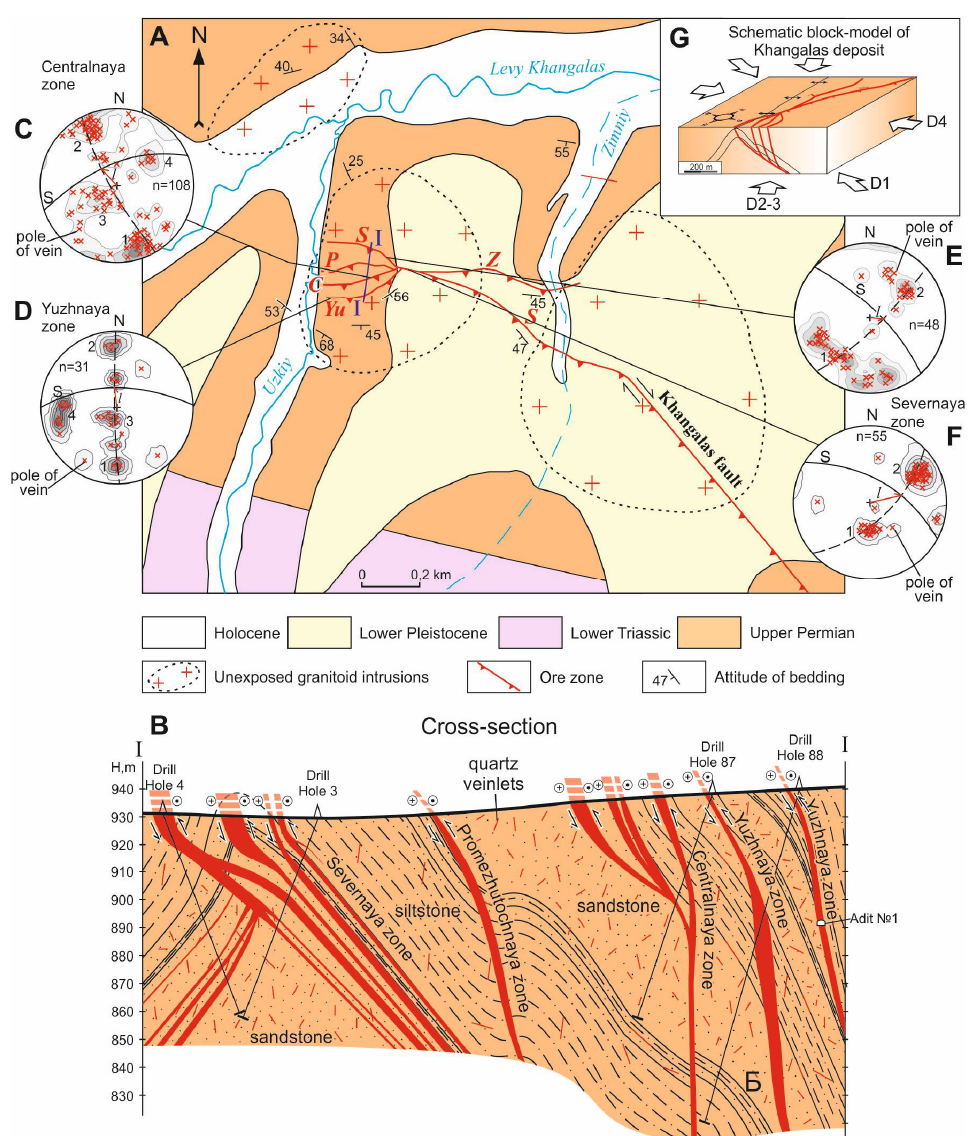
Figure 3. Geological sketch map ( A ), cross-section ( B ) and stereograms of the quartz veins poles ( C – F ), Khangalas deposit. In Figure ( A ), the I-I line shows the position of the cross-section ( B ). Mineralized fault zones: S, Severnaya; P, Promezhutochnaya; C, Centralnaya; Yu, Yuzhnaya; Z, Zimnyaya. Symbols in stereograms and figures hereafter are: S, position of fault or ore zone; l , calculated direction of rock motion; n, number of measurements; dashed line, belt of vein poles. Contours of poles to planes (per 2% area).